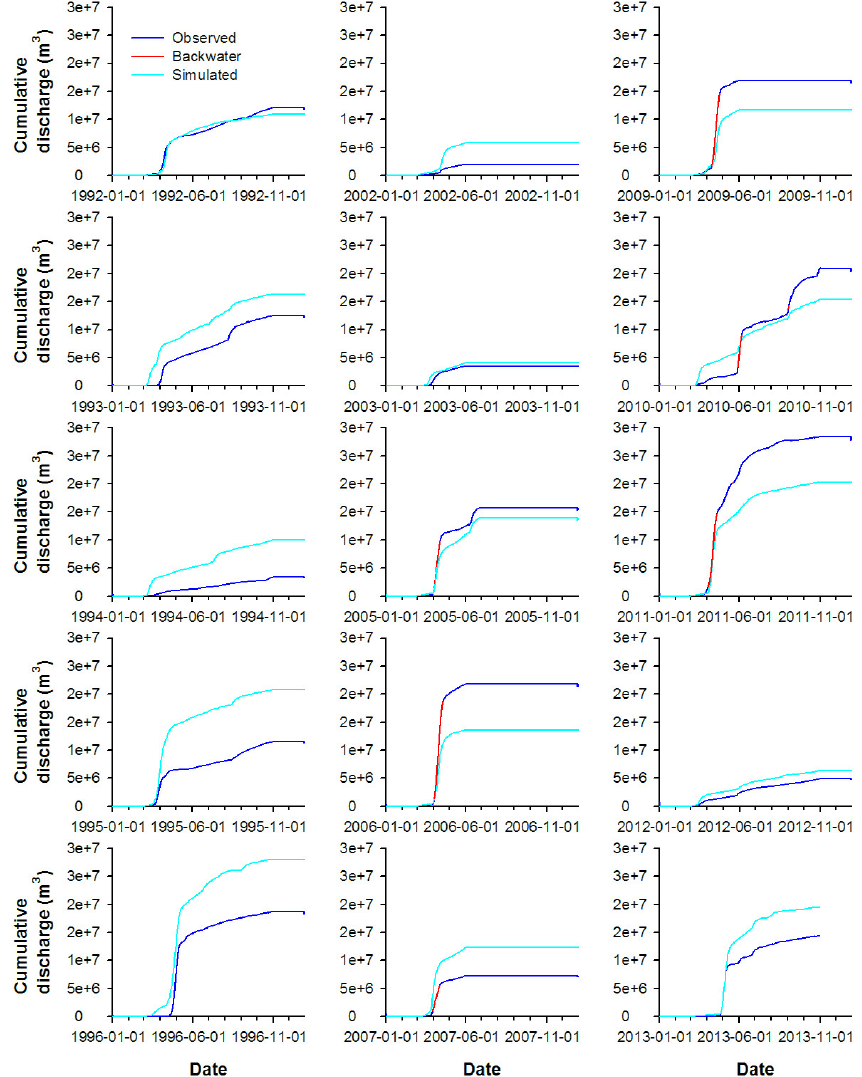
Figure 5. Comparison of observed and simulated annual cumulative discharge between 1992 and 2013 for years with good records in the HYDAT